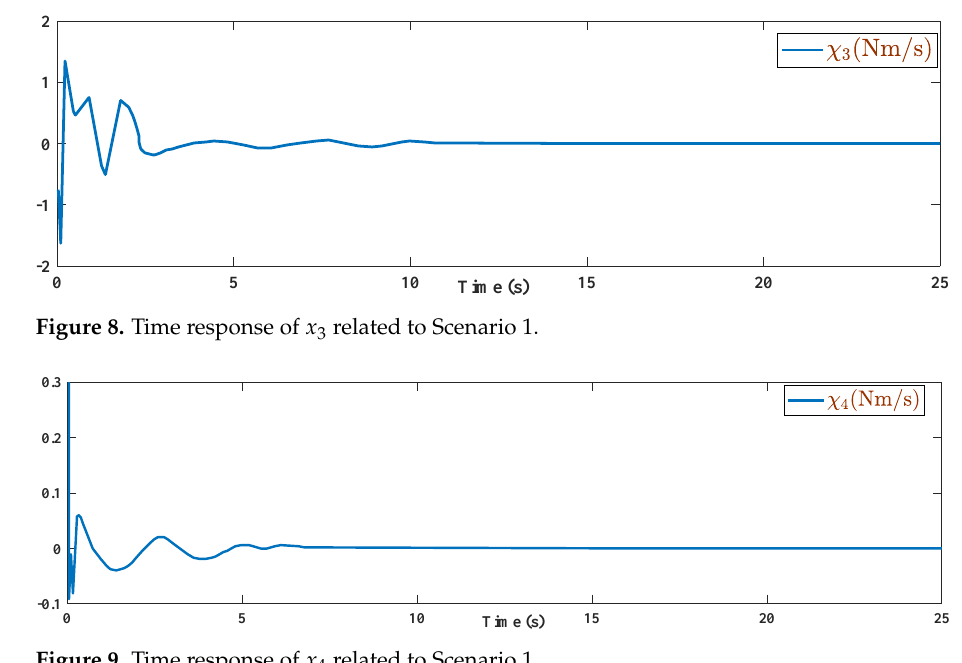
Figure 9. Time response of x 4 related to Scenario 1.